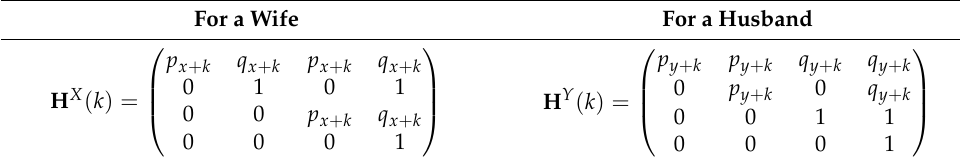
Table 2. The process duration matrixes for a marriage reverse annuity